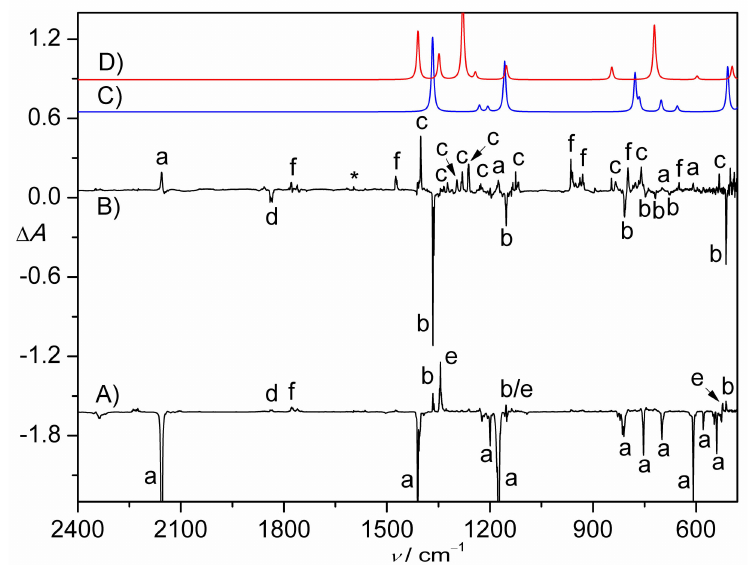
Figure 3. ( A ) IR difference spectrum (Absorbance, ∆ A ) showing the decomposition of CHCl 2 S(O) 2 N 3 in N 2 -matrix upon a 193 nm laser photolysis (11 min); ( B ) IR difference spectrum (Absorbance, ∆ A ) showing the change of the N 2 -matrix upon subsequent UV-light photolysis (365 nm, 10 min). ( C ) Calculated IR spectrum of triplet CHCl 2 S(O) 2 N at the B3LYP/6-311++G(3df,3pd) level. ( D ) Calculated IR spectrum of CHCl 2 NSO 2 (singlet-II) at the B3LYP/6-311++G(3df,3pd) level. The IR bands of CHCl 2 SO 2 N 3 (a), CHCl 2 SO 2 N (b), CHCl 2 NSO 2 (c), CHCl 2 S(O)NO (d), SO 2 (e), unknown species (f), and impurity H 2 O (*) are labeled. For clarity, the spectra are arbitrarily shifted along the ∆ A